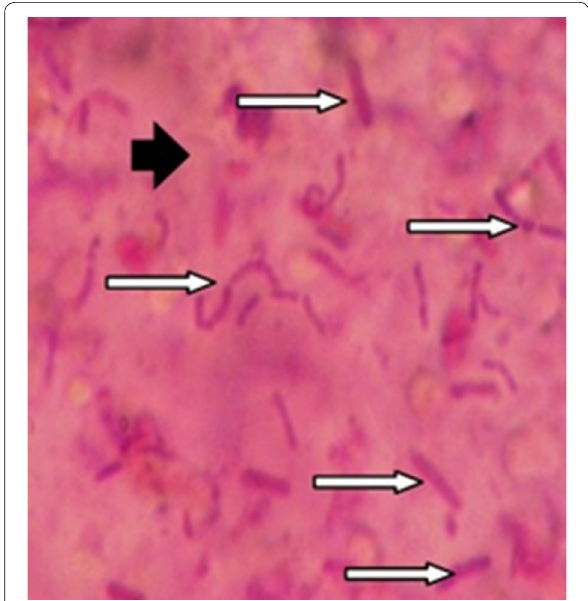
Fig. 3 Vertical cross-section and internal appearance of bead at 100 magnification after gram staining [see the positive gram bac- × teria ( rightwards black arrow ) are distributed randomly in the alginate matrix ( rightwards white arrow